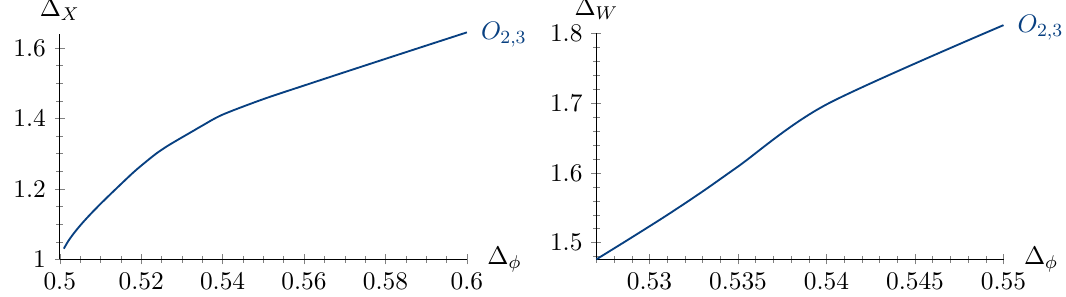
0 . 5 Figure 6: Upper bound on the dimension of the first scalar X and the first scalar W × φ operator in the φ OPE as a function of the dimension of φ in the O ar bs (C-1) saturation of X bound of Fig.